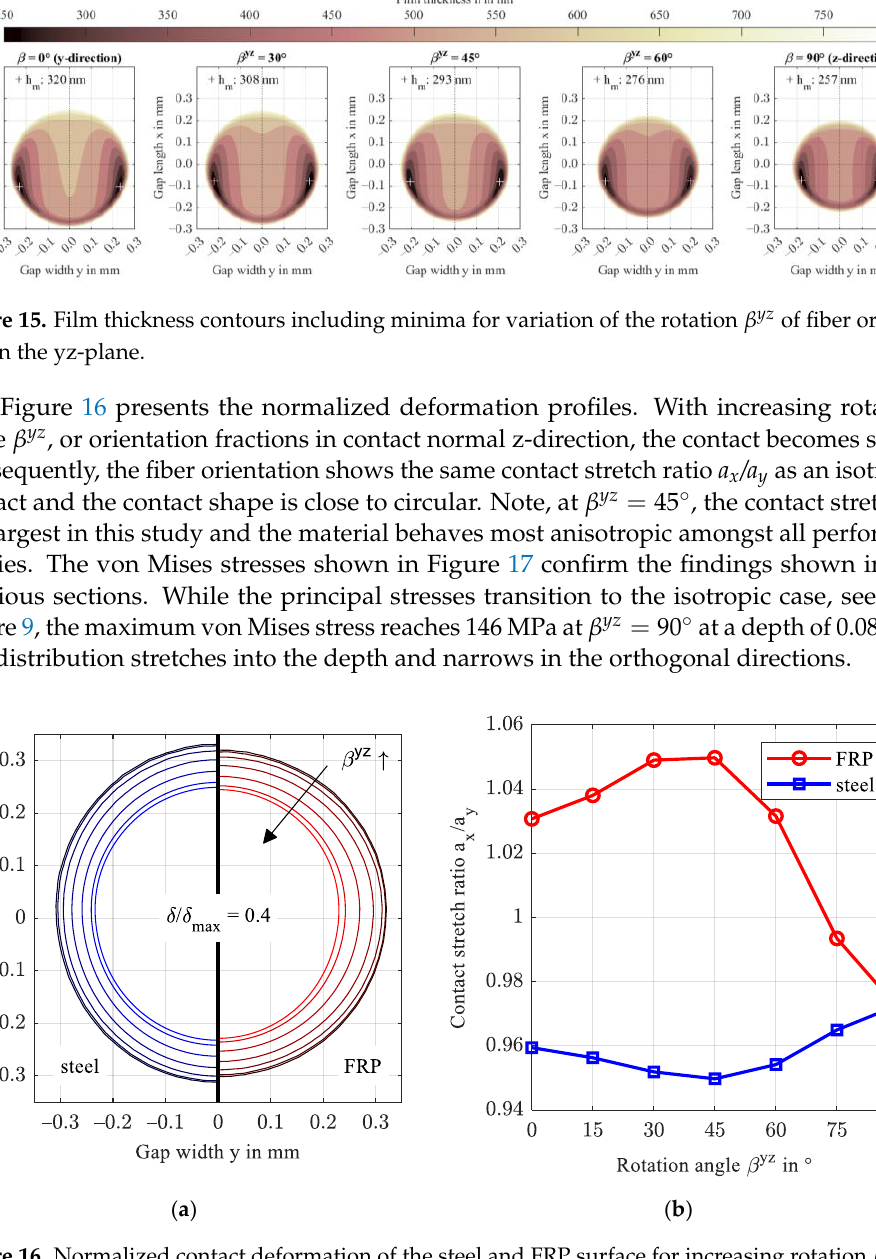
Figure 14. Hydrodynamic pressure p and film thickness h profiles along the gap length x at y = 0 ( left ) and along the gap width y at x = 0 ( right ) for rotation 𝛽 𝑦𝑧 of fiber orientation in the yz- plane.